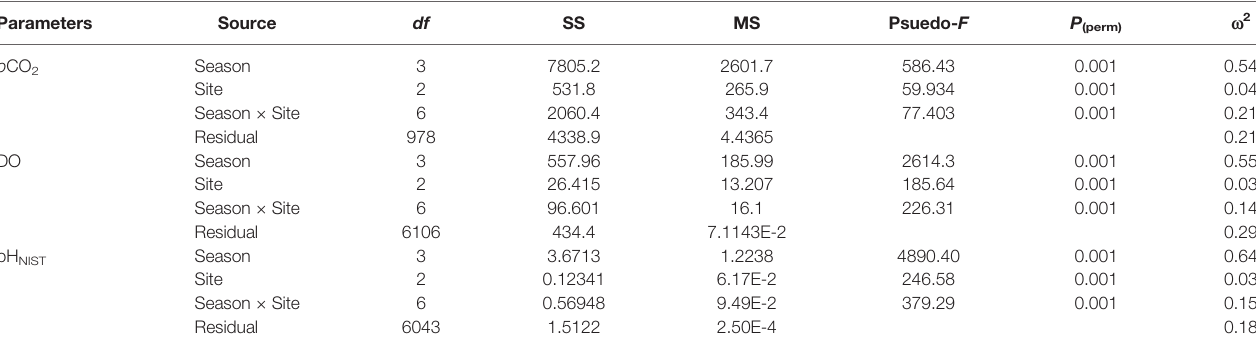
TABLE 5 | Results of two factor Model I PERMANOVAs testing the effects of season and site on the in-situ monitoring parameters (partial pressure of CO 2 : p CO 2 , dissolved oxygen concentration: DO, and pH on the scale of National Institute of Standards and Technology: pH NIST ). The magnitudes of effect ( w 2 ) represent the percentage of variation in each response variable that is explained by each factor in the models.